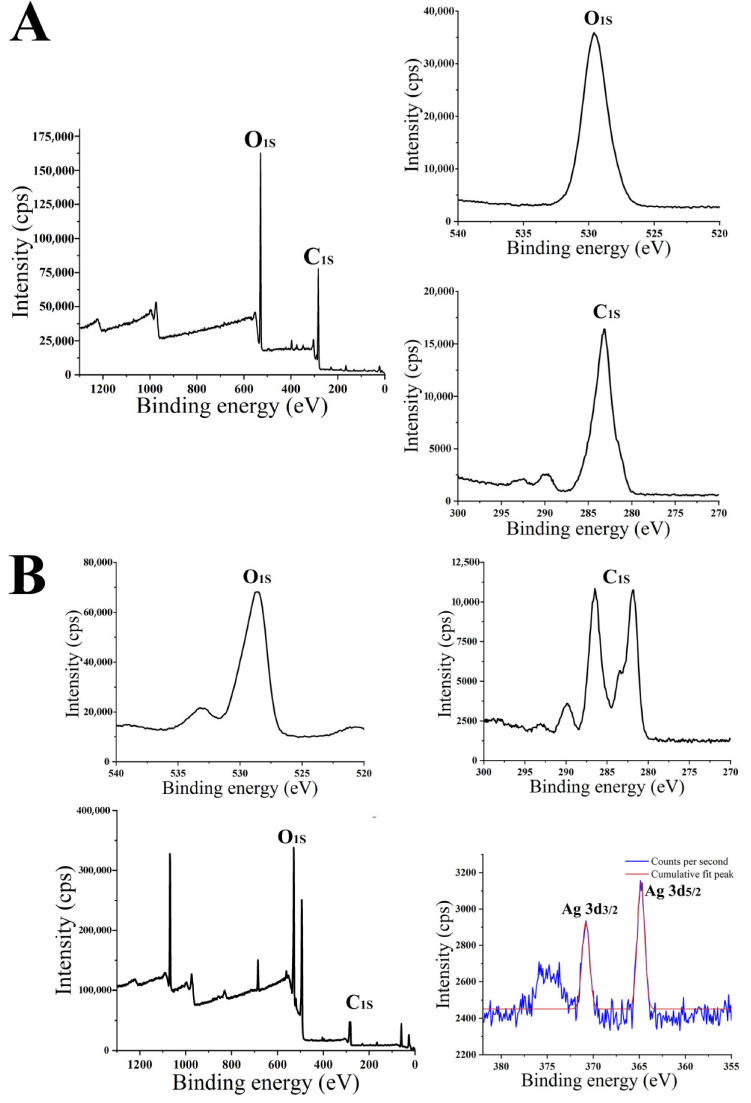
Figure 2. The XPS results of ( A ) HPS and ( B )